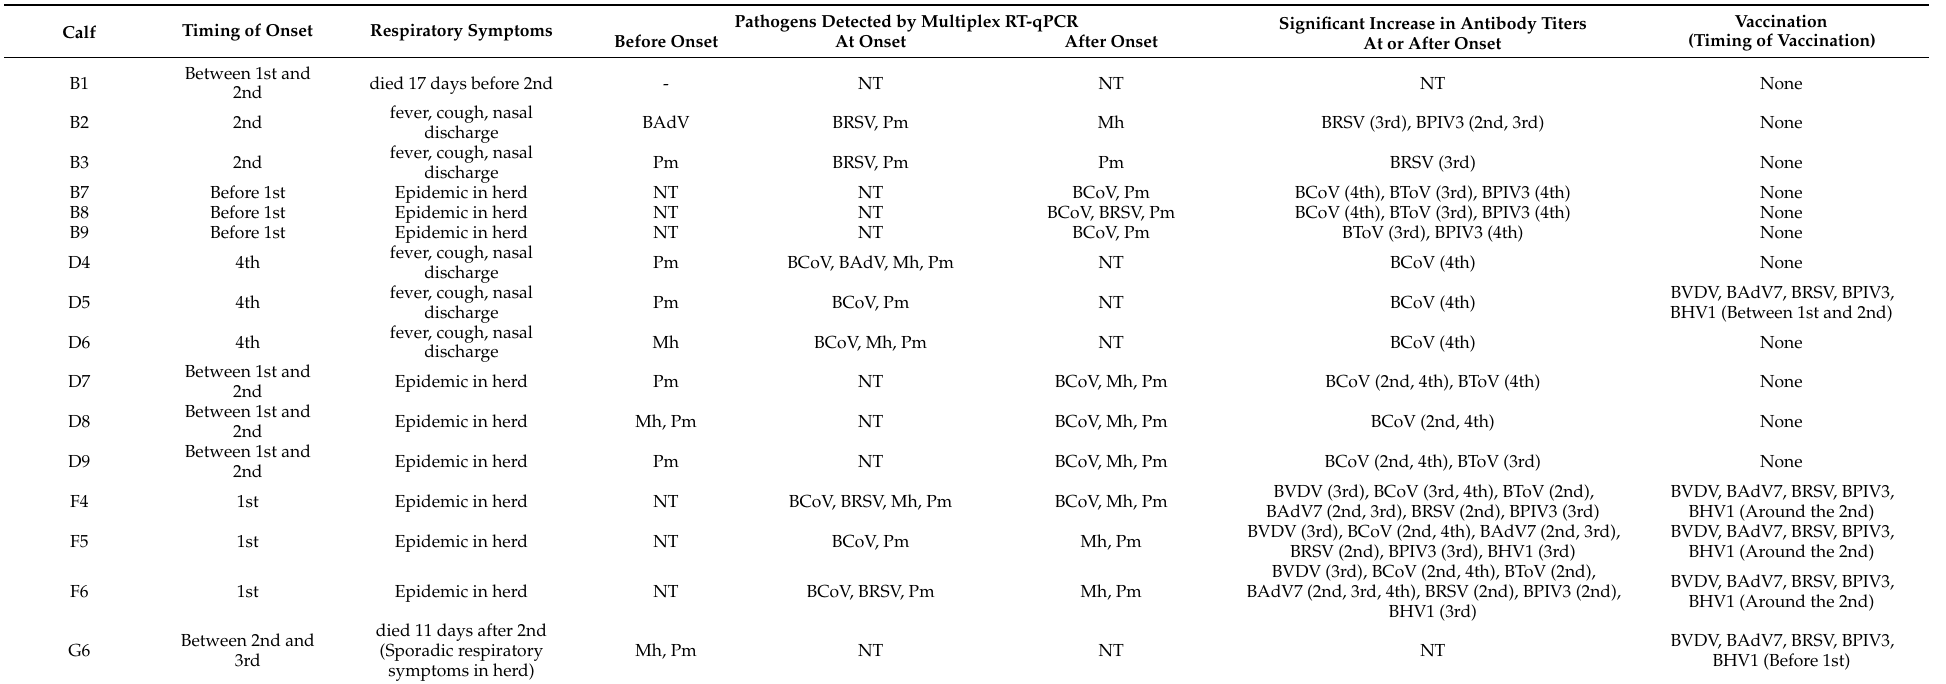
Table 5. Summary of the status of pathogen detection by multiplex real-time RT-PCR before and after the onset of the disease and a significant increase in antibody titers after onset by virus neutralization test in 16 calves with respiratory disease among 63 clinically healthy